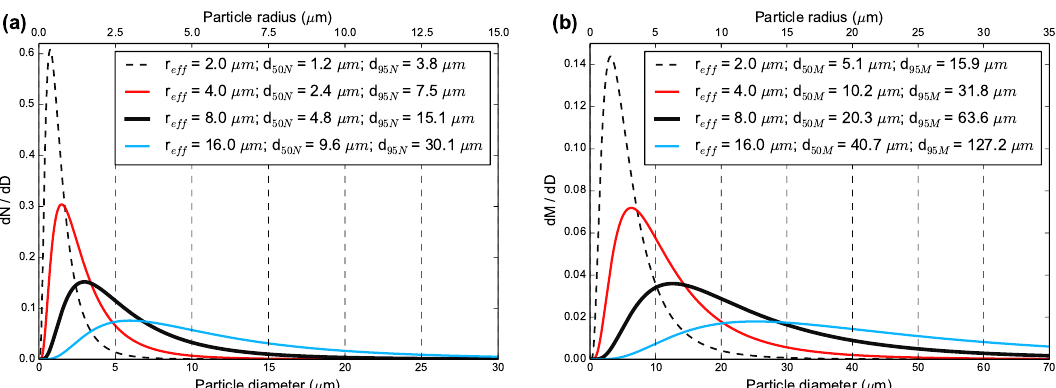
Figure 1. Lognormal number (a) , and mass (b) , grain-size distributions corresponding to different effective radii, assuming that particles are dense spheres. The mass distribution is shifted towards coarser values compared to the number distribution. The mass median diameter and mass 95th percentile diameter are approximately 2.5 × and 8 × r eff . For r eff >8µm, more than half of the mass of the distribution is contained in cryptotephra-sized particles (>20µm diameter), but only distributions with larger r eff contain significant proportions of the coarsest cryptotephra-sized particles (i.e. >100µm). If the geometric standard deviation is less than 2.0, the size of the coarsest particles is much